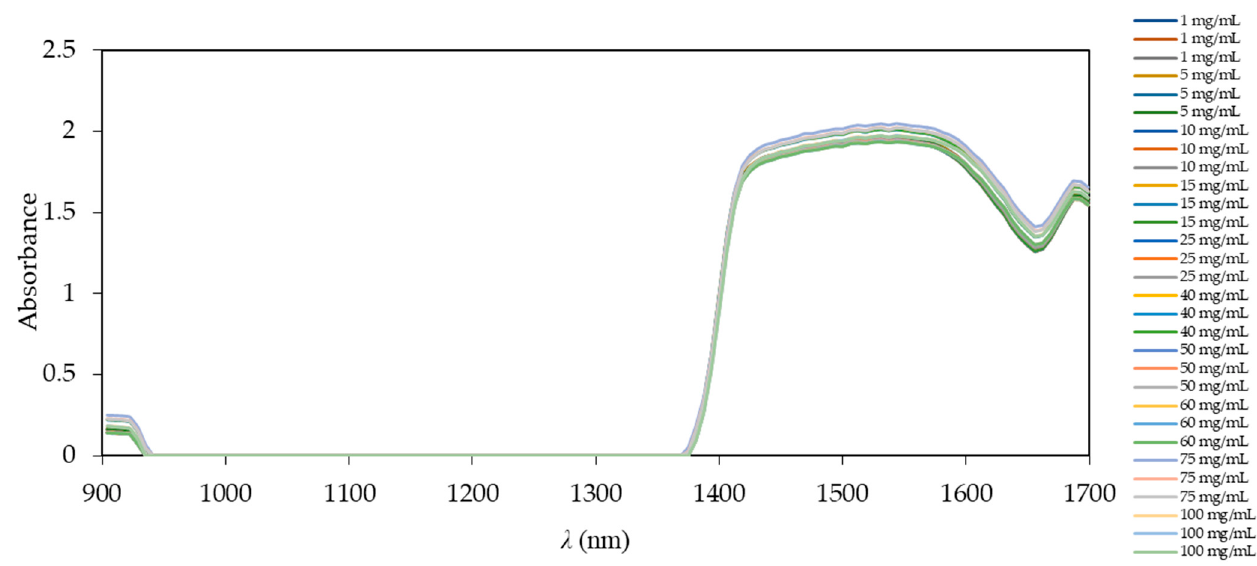
Figure 4. NIR spectra of glycerol concentrations in model samples ranging from 0 to 100 mg/mL. Triplicates of each concentration are given in the legend.